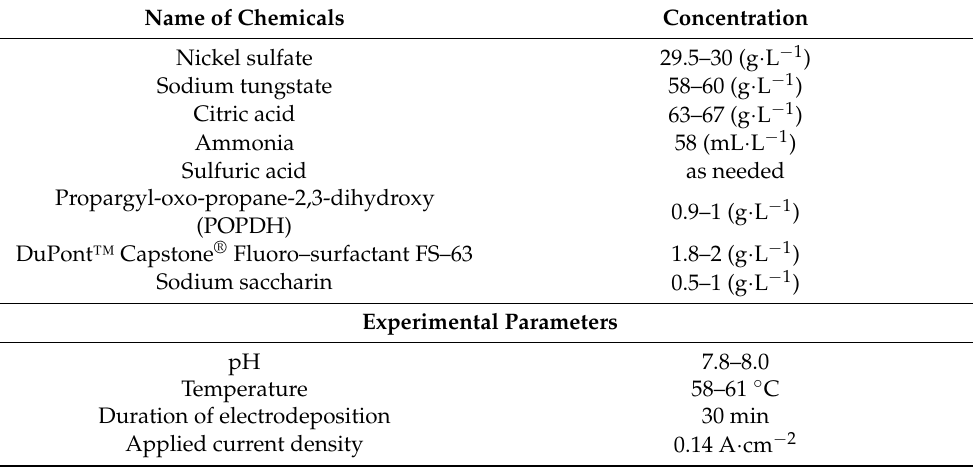
Table 1. Electrodeposition bath ingredients and optimized experimental